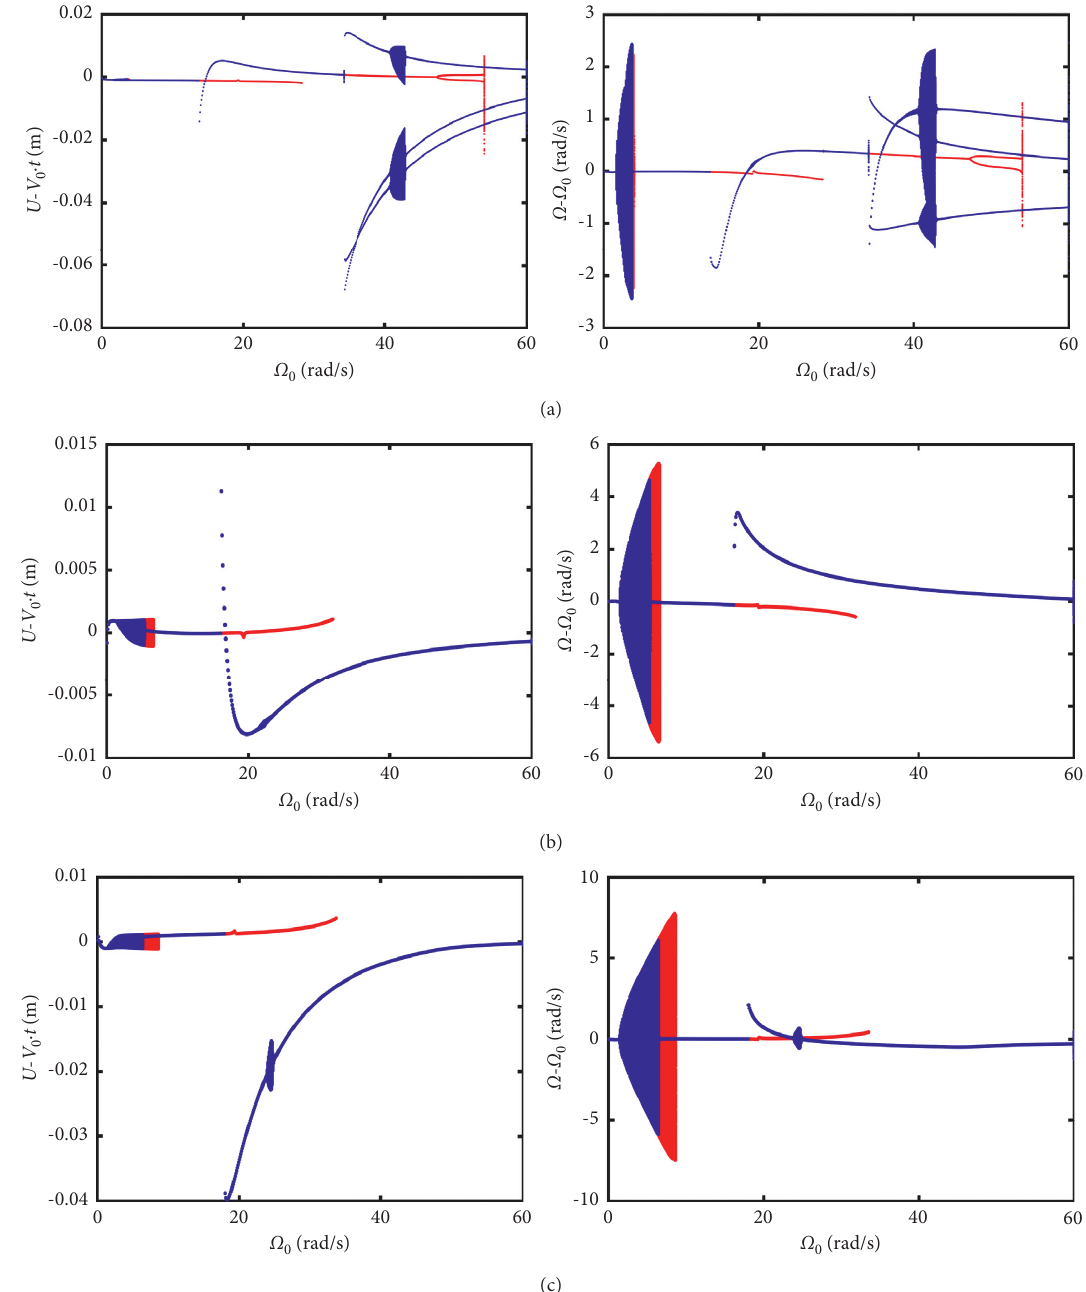
Figure 6: The bifurcation diagram responding to the variation of the driving angular velocity of the turntable, k (b) W 0 � 100, and (c) W 0 �